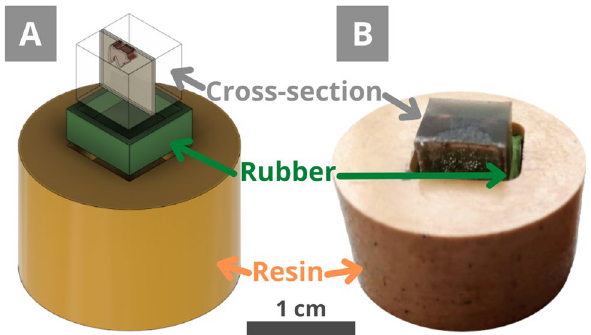
Figure 5. (A) Scheme of the holder with the LevoFast resin, a silicone rubber, and a cross-section (Fig. 4F) to be polished. (B) The achieved holder for the 1 cm × 1 cm × 1 cm